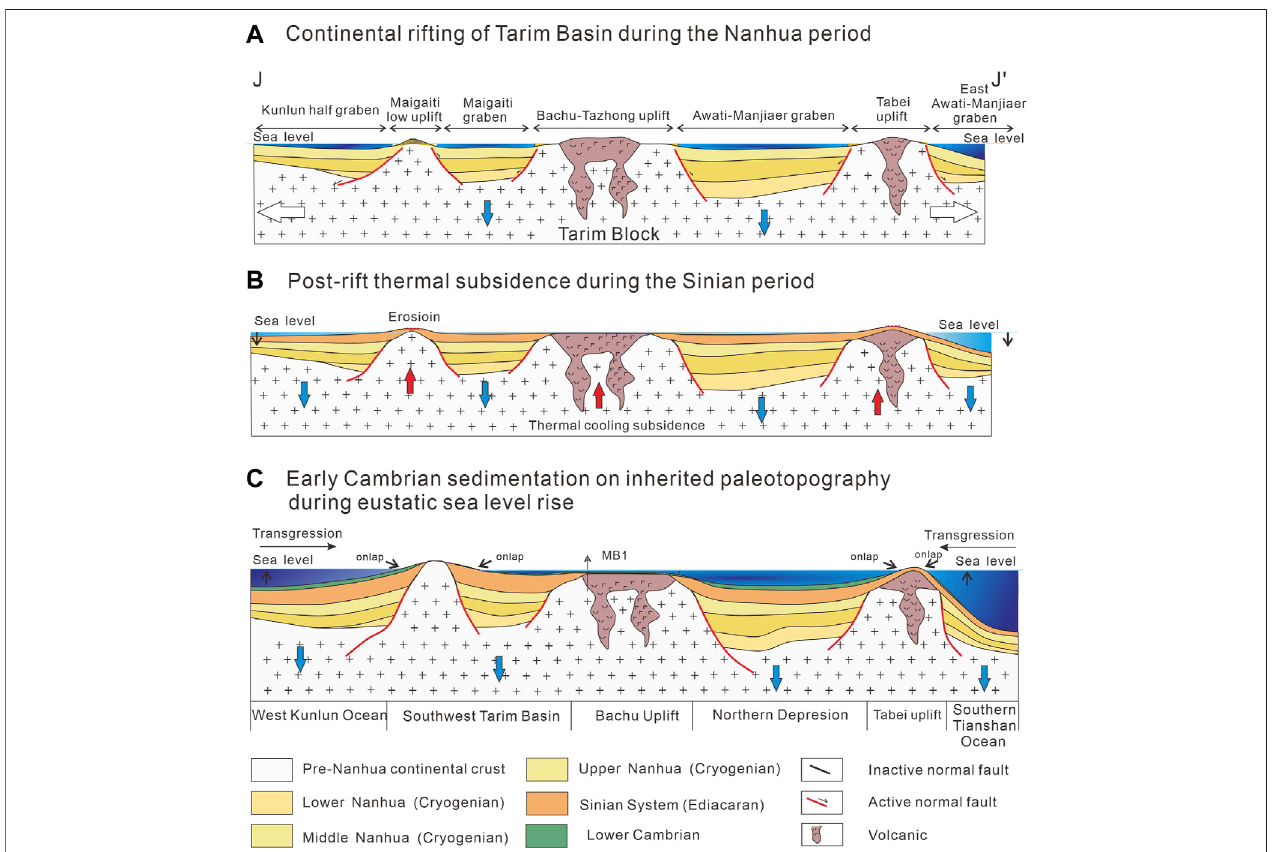
FIGURE 12 | Sequential tectonic diagrams depicting the geological evolution of the Tarim Basin ( Figure 3 for locations).